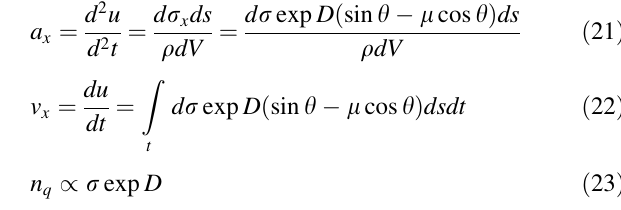
Fig. 12 Crack of coal variation and analysis. a The crack of coal, b Analysis for a